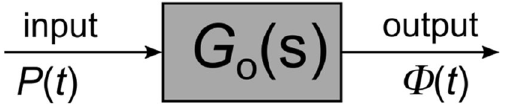
Figure 1. The structure of the model